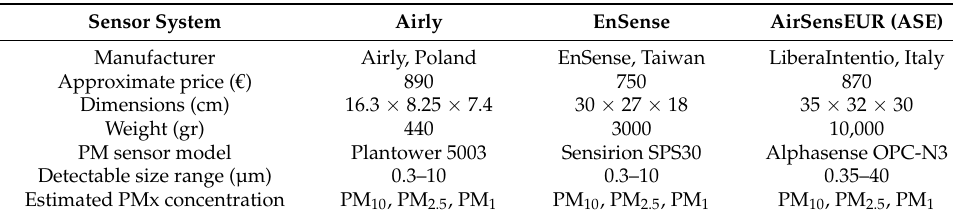
Table 1. Characteristics of PM low-cost sensor systems used in the